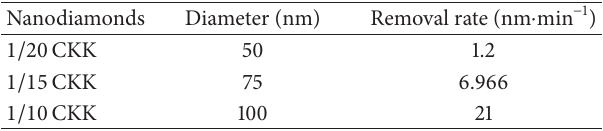
Table 3: Comparison of removal rates of nanodiamonds with different